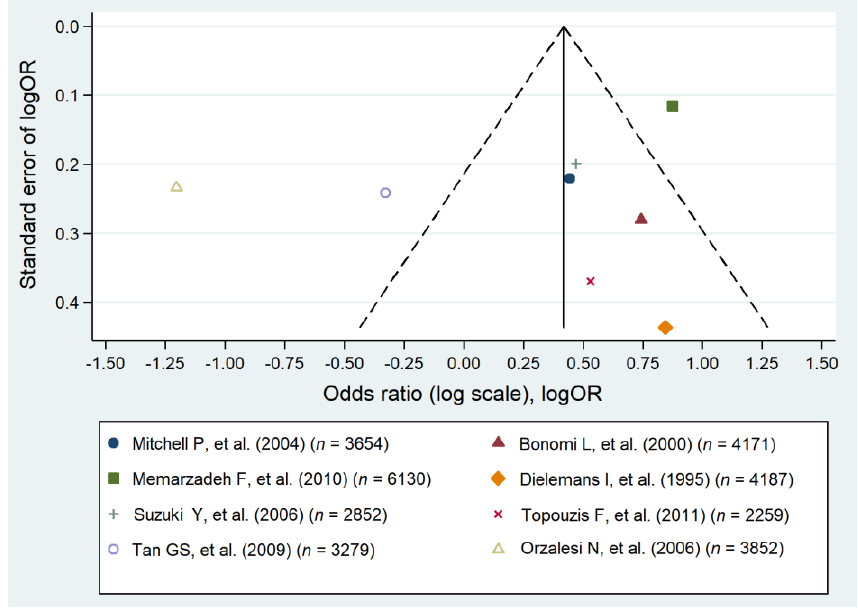
Figure 2. Funnel plot of cohort studies that evaluated arterial hypertension as a risk factor for primary open angle glaucoma [31,33,35,40,42,46,49,50].